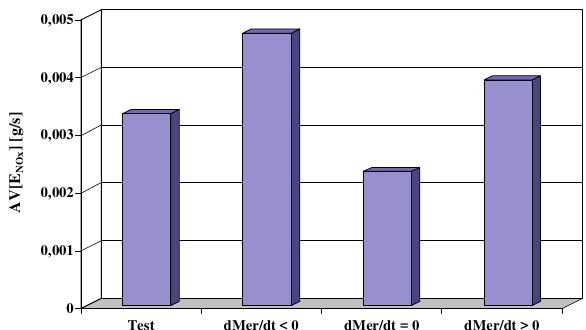
Fig. 16. The average value of the carbon monoxide emission in the NEDC test and in the states corresponding to the negative, zero and positive time derivative values of the engine torque